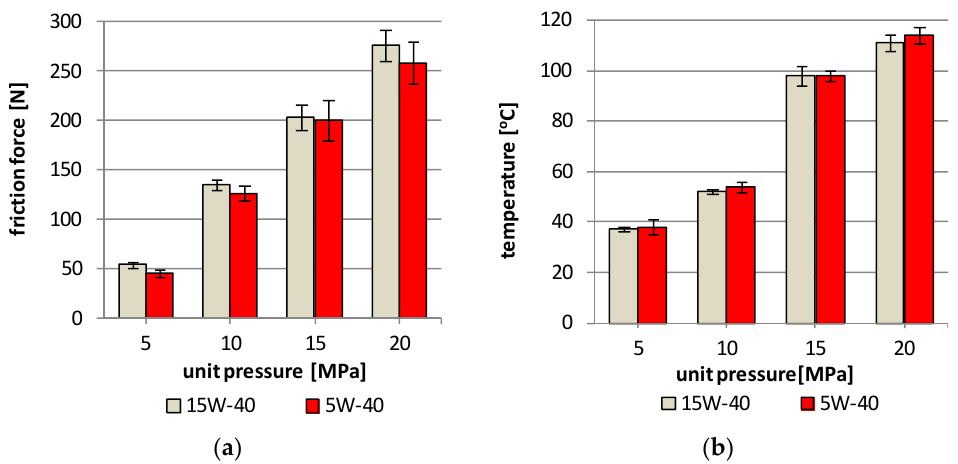
Figure 6. Friction forces ( a ) and temperature in friction area ( b ) vs unit pressure (at 100 rpm and after 500 s).